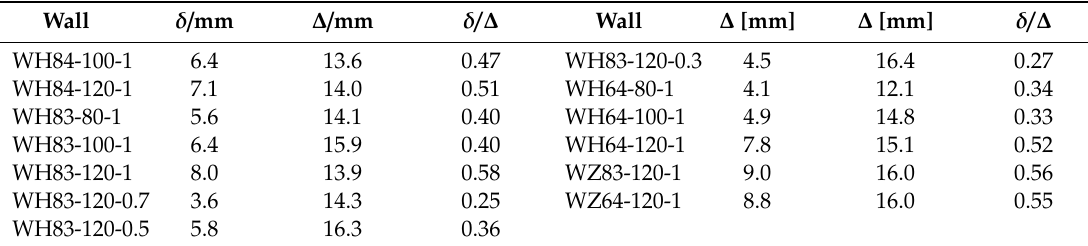
Table 4. Relative displacement δ / ∆ .